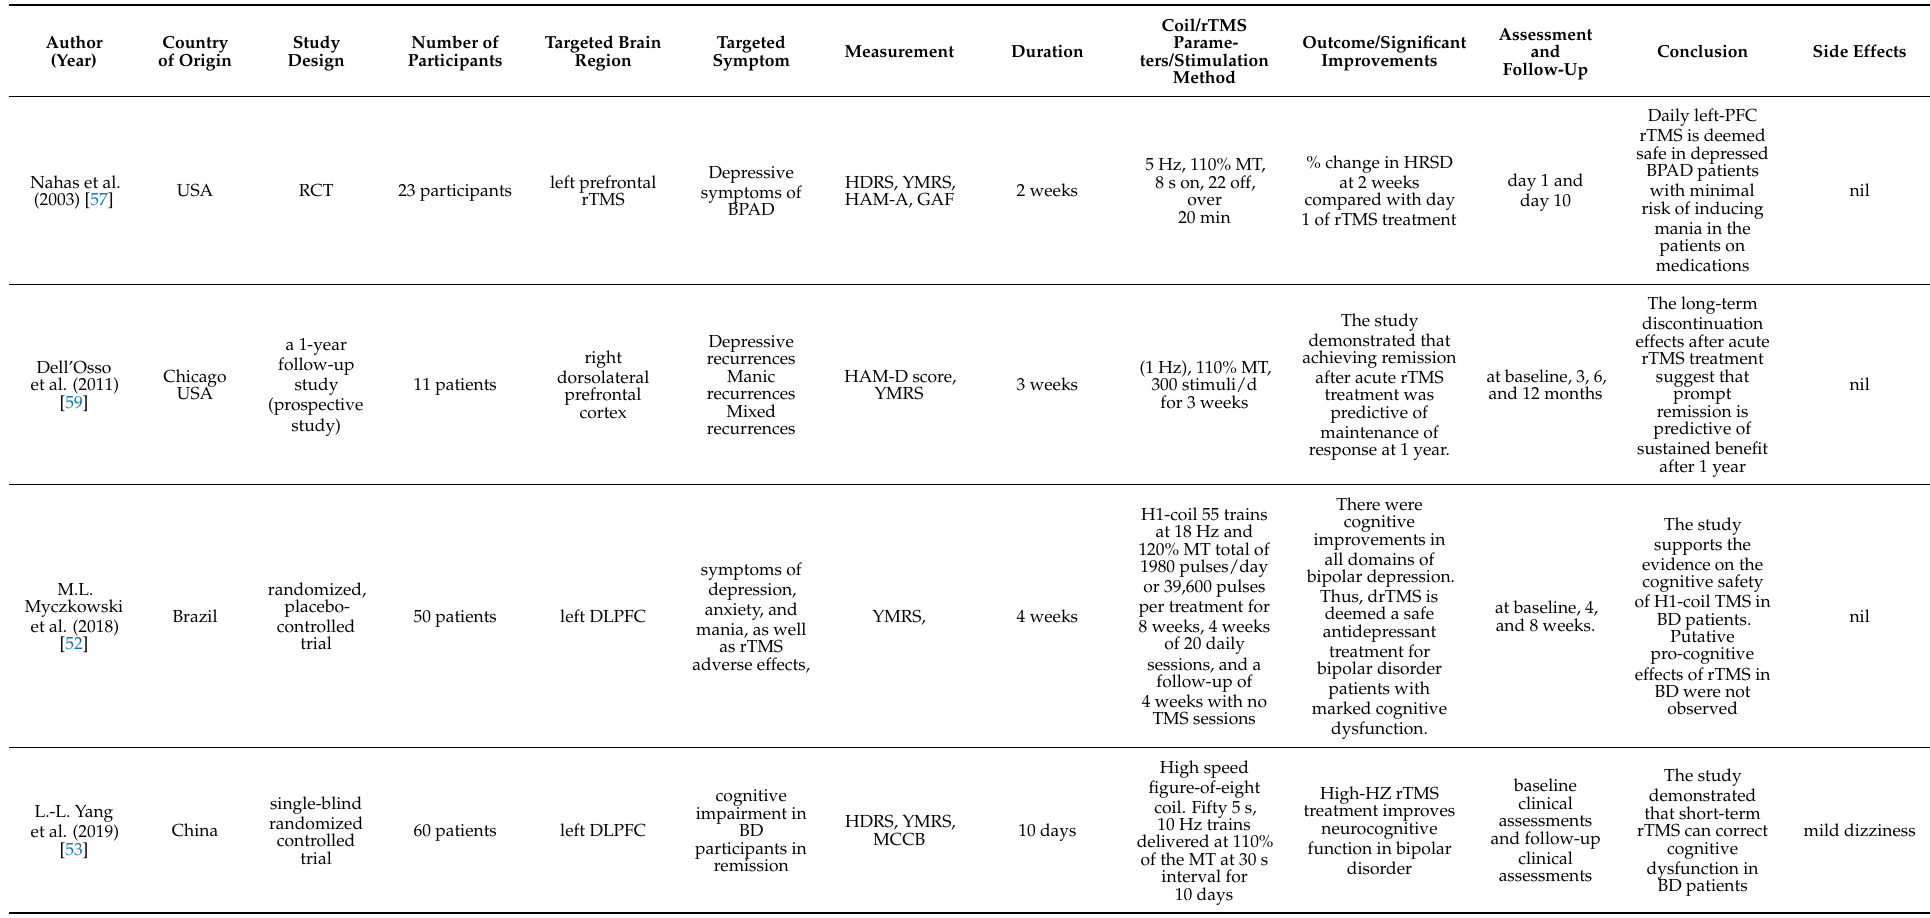
Table 2. Summary of studies using rTMS for the treatment of bipolar